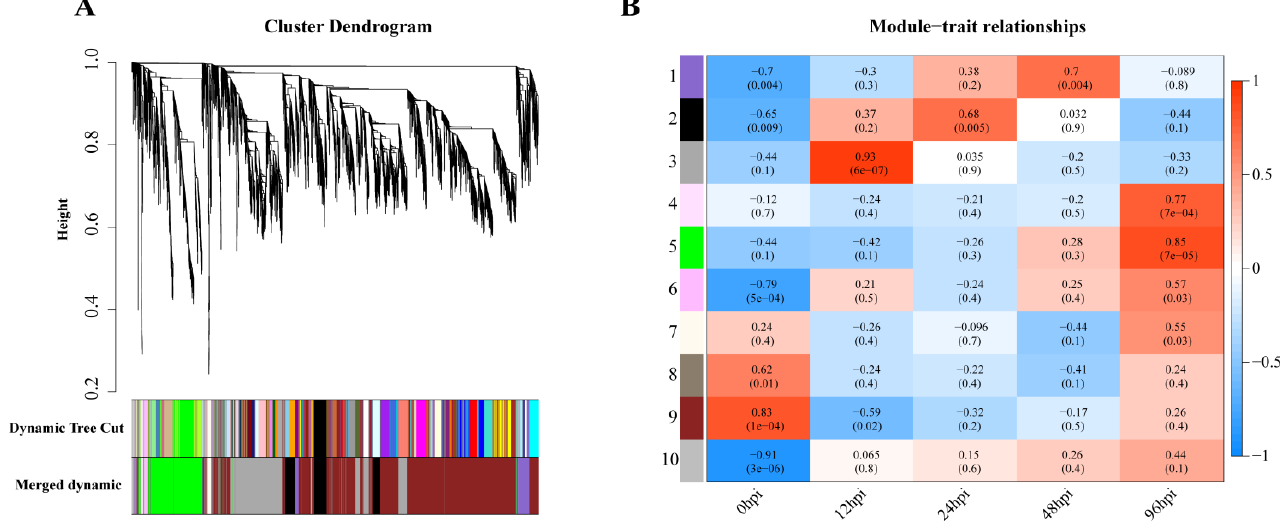
Figure 4. Gene modules in a weighted gene coexpression network analysis (WGCNA). ( A ) Hierarchical cluster trees (cluster trees) represent identified coexpressed gene modules at different stages of infection. Height ( Y -axis) represents coexpression distance, and the X -axis corresponds to genes. In WGCNA convention, genes within different modules are labeled with different colors. ( B ). Heat map showing the relationship between modules and traits. Red indicates a positive correlation (0 < r < 1) between modules and infection stages, while blue indicates a negative correlation ( − 1 < r < 0).